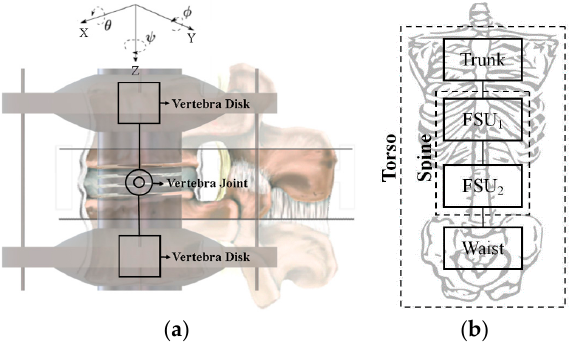
Figure 2. Conceptual design for a humanoid torso: ( a ) human-inspired FSU scheme, ( b ) structure of the CAUTO torso.